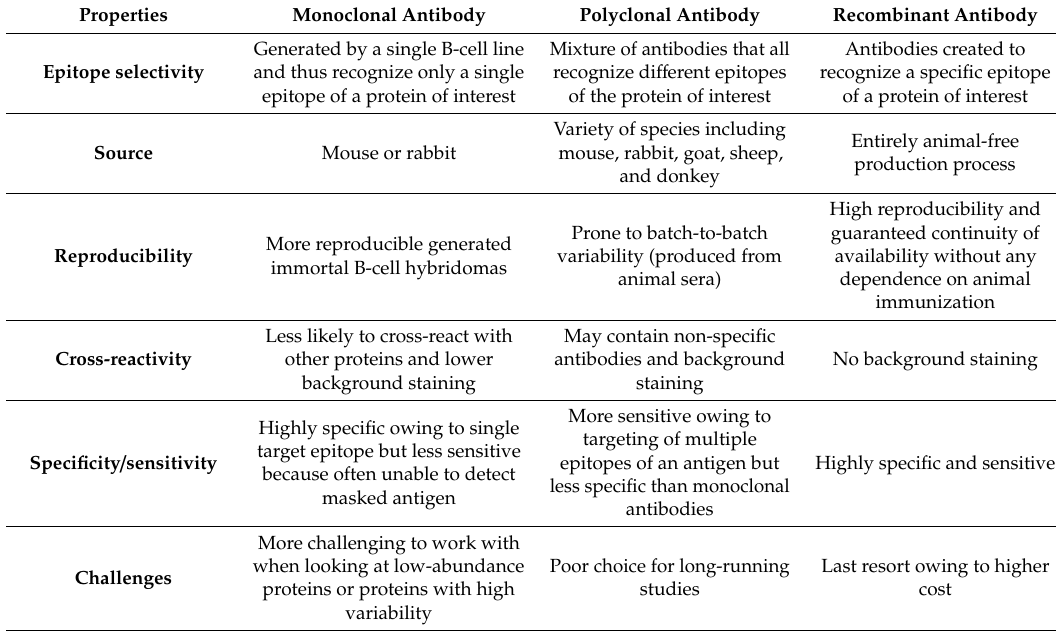
Table 1. Antibody properties and